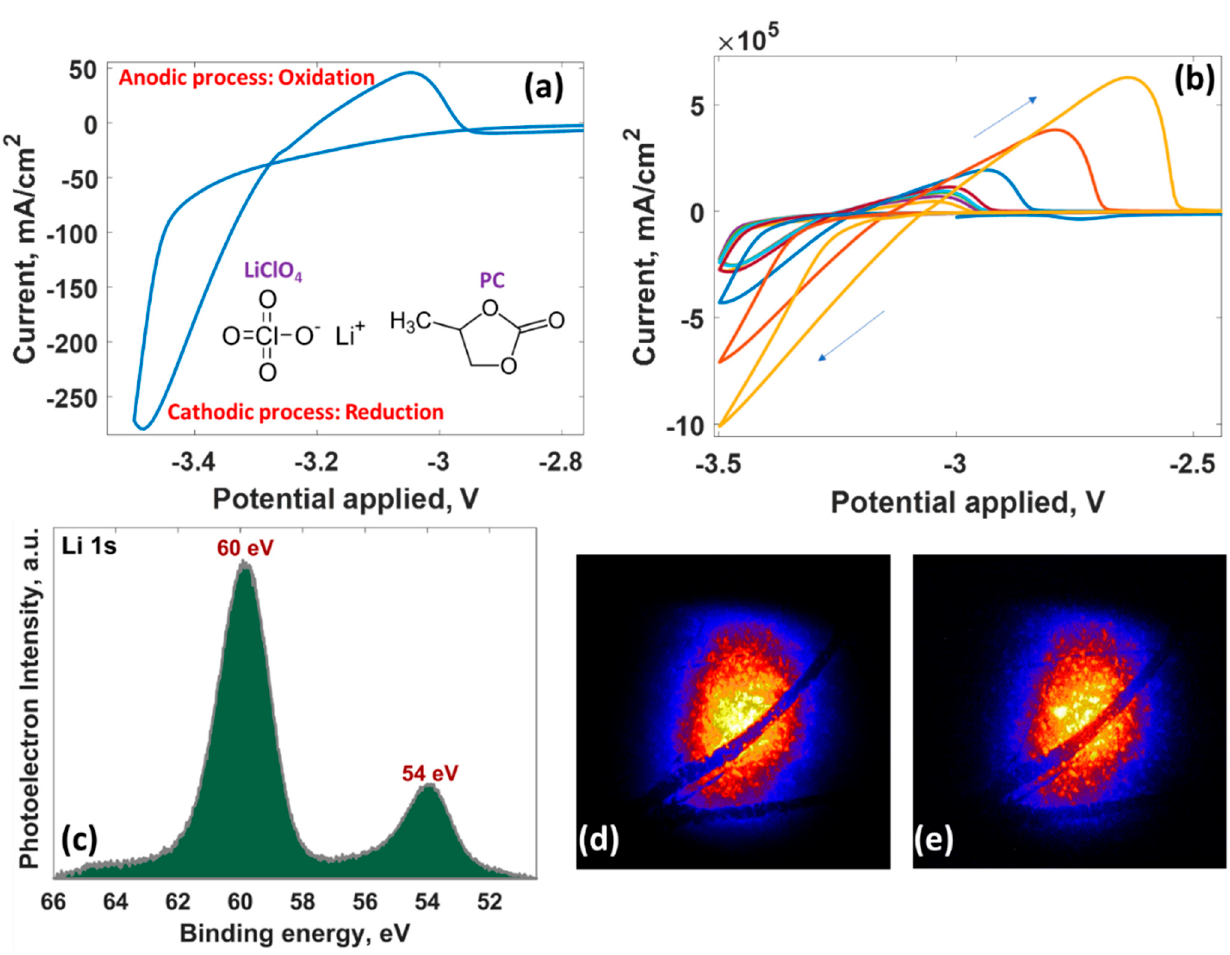
Figure 5. Cyclic voltametric data for the reduction/oxidation of Li + /Li 0 at BLPMLG/SiC electrode in PC|LiClO 4 electrolyte after first cycle ( a ) and after 11 cycles ( b ). ( c ) XPS spectrum of Li 1 s core-level peak, background subtracted. Elemental XPEEM contrast images of the lithiated BLPMLG/SiC electrode BLPMLG/SiC for Li 1 s peak at ( d ) 60 eV and ( e ) 54 eV. Field of view, 50 µ m. The size of the photon beam is 15(h) × 20(v) μ m 2 .